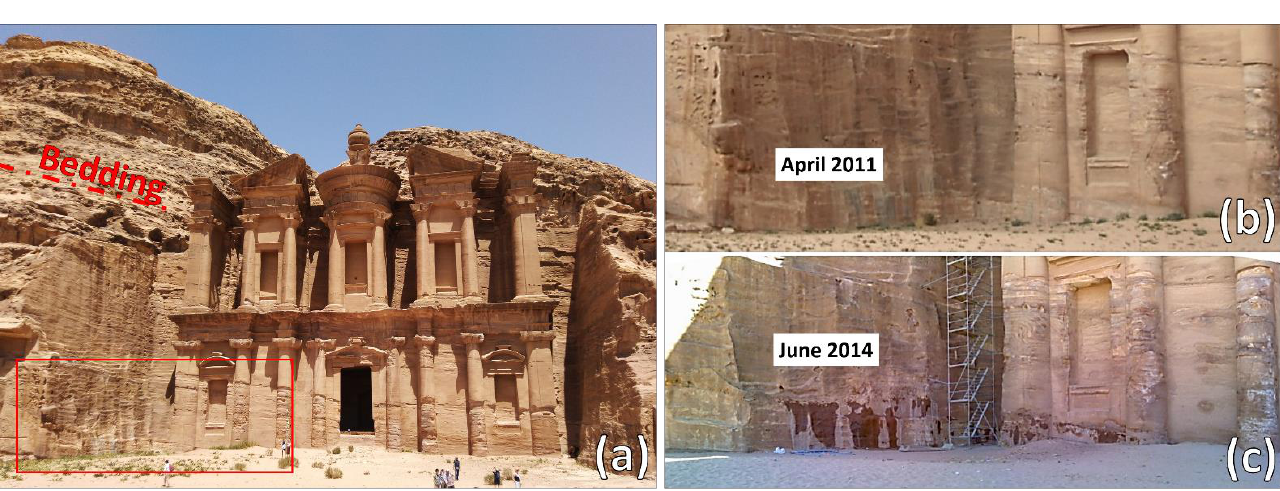
Figure 5. The Monastery of Petra: rock mass on the right side of the monument showing the area of interest (red rectangle) and bedding of the sandstones ( a ); pictures of the area of interest during the surveys of April 2011 ( b ) and June 2014 ( c ).